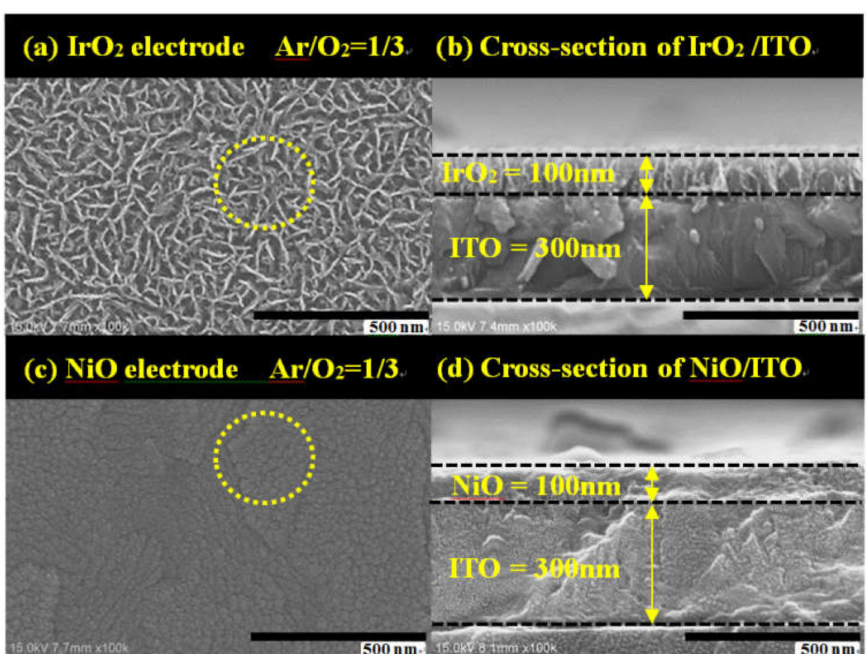
Figure 5. SEM images of surface morphology ( a ) IrO 2 electrode with Ar/O 2 = 1/3 ( c ) NiO electrode with Ar/O 2 = 1/3; Cross-section morphology of ( b ) IrO 2 electrode with thickness 100 nm ( d ) NiO electrode with a thickness of 100 nm.